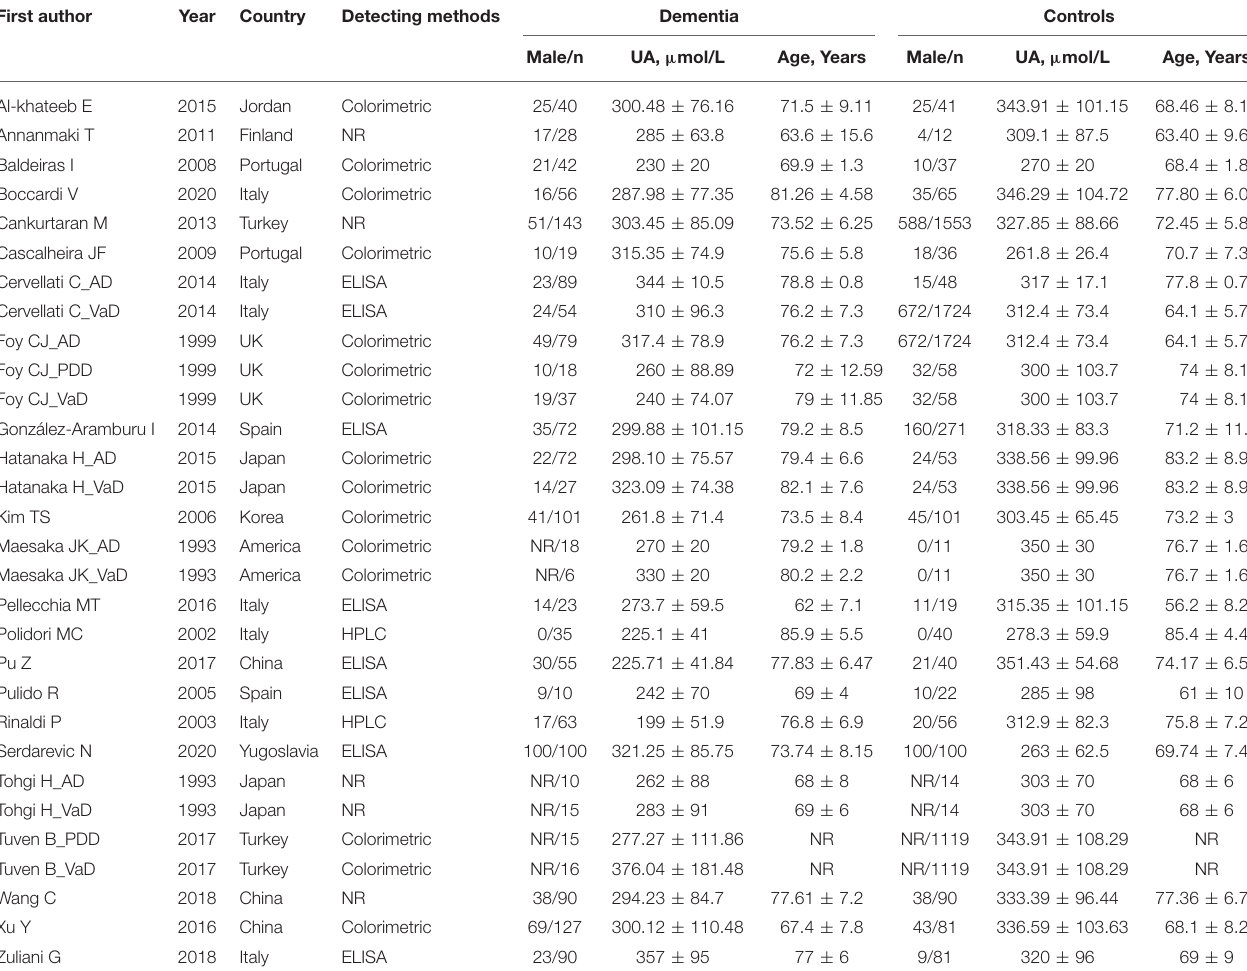
TABLE 1 | General characteristics of population-based studies on serum UA and